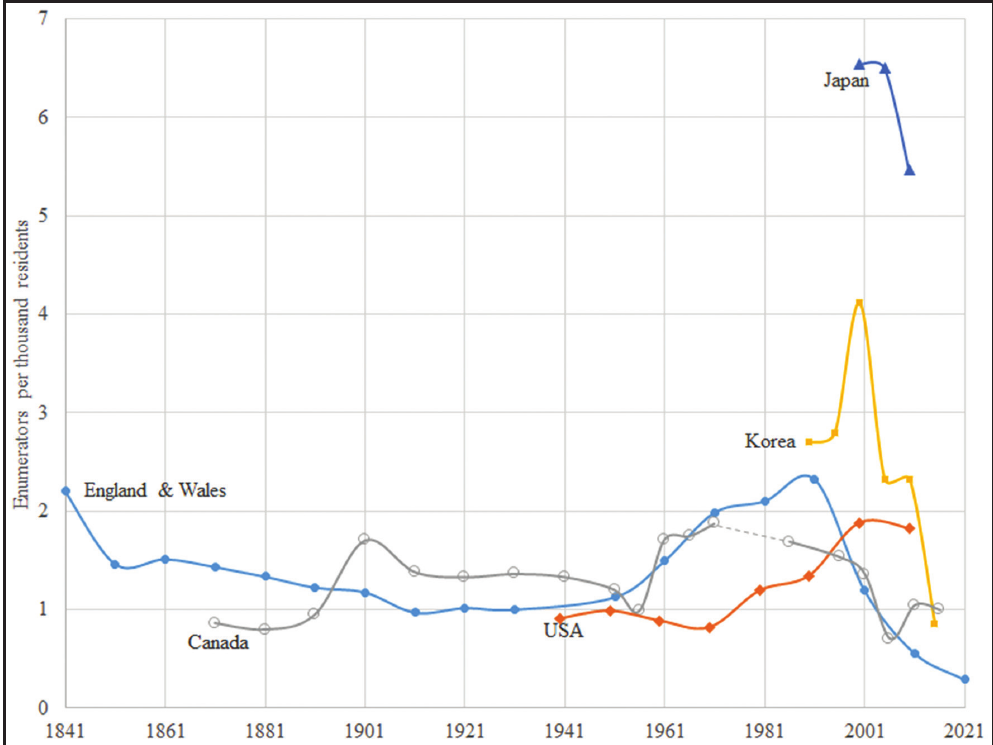
Employment intensity. See Appendix A for